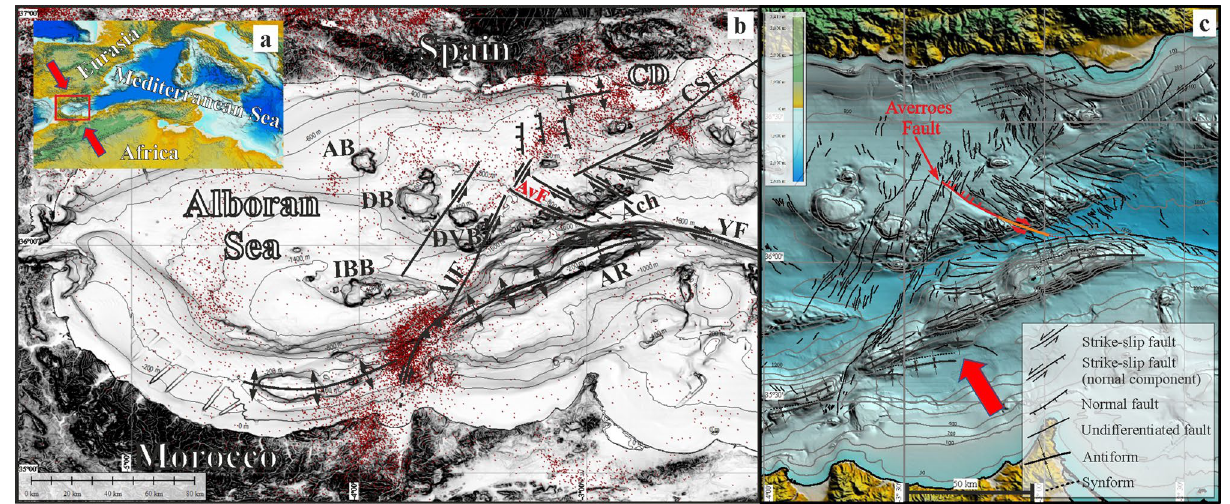
Figure 1. The Averroes Fault in the tectonic framework of the Alboran Sea. ( a ) Location of the study area; ( b ) Multibeam bathymetric map displaying the main NNE-SSW shear zone seismicity (red dots) and main tectonic features and seamounts; ( c ) detailed tectonic map of the central Alboran Sea highlighting the presence of the Averroes Fault northern segment in red and southern segment in orange. Modified from Estrada et al. 15 . ACh Alboran Channel, AR Alboran Ridge, AB Algarrobo Bank, DB Djibouti Bank, DVB Djibouti Ville Bank, IBB Ibn Batouta Bank, CD Campo de Dalias, YF Yusuf Fault, AIF Al Idrisi Fault, AvF Averroes Fault, CSF Carboneras- Serrata Fault. Red arrow indicates direction of tectonic indentation. (Figures generated using Globalmapper v.19, https:// www. bluem arble geo. com, and mounted with CorelDRAW v. X7, https:// www. corel.